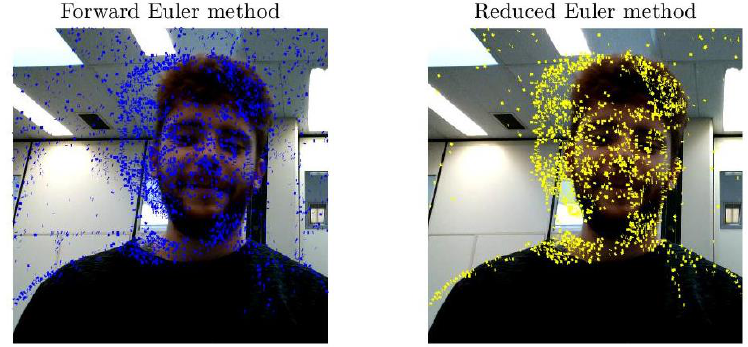
Figure 6. Results of optical-flow estimation when the windows size was set to 3 × 3.